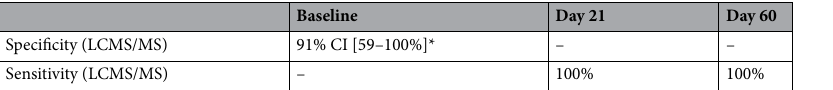
Table 4. Sensitivity and specificity of detecting MPA in urine samples of DMPA users (n = 15). *n = 11 samples with undetectable MPA at baseline. MPA Detection in urine and serum samples of Depo-Provera users (n = 15) at Baseline. We observed 91% specificity pre-dose in urine. 10/11 women (91%) had undetectable MPA at baseline. The serum level for 2 out of 4 women was < 0.2